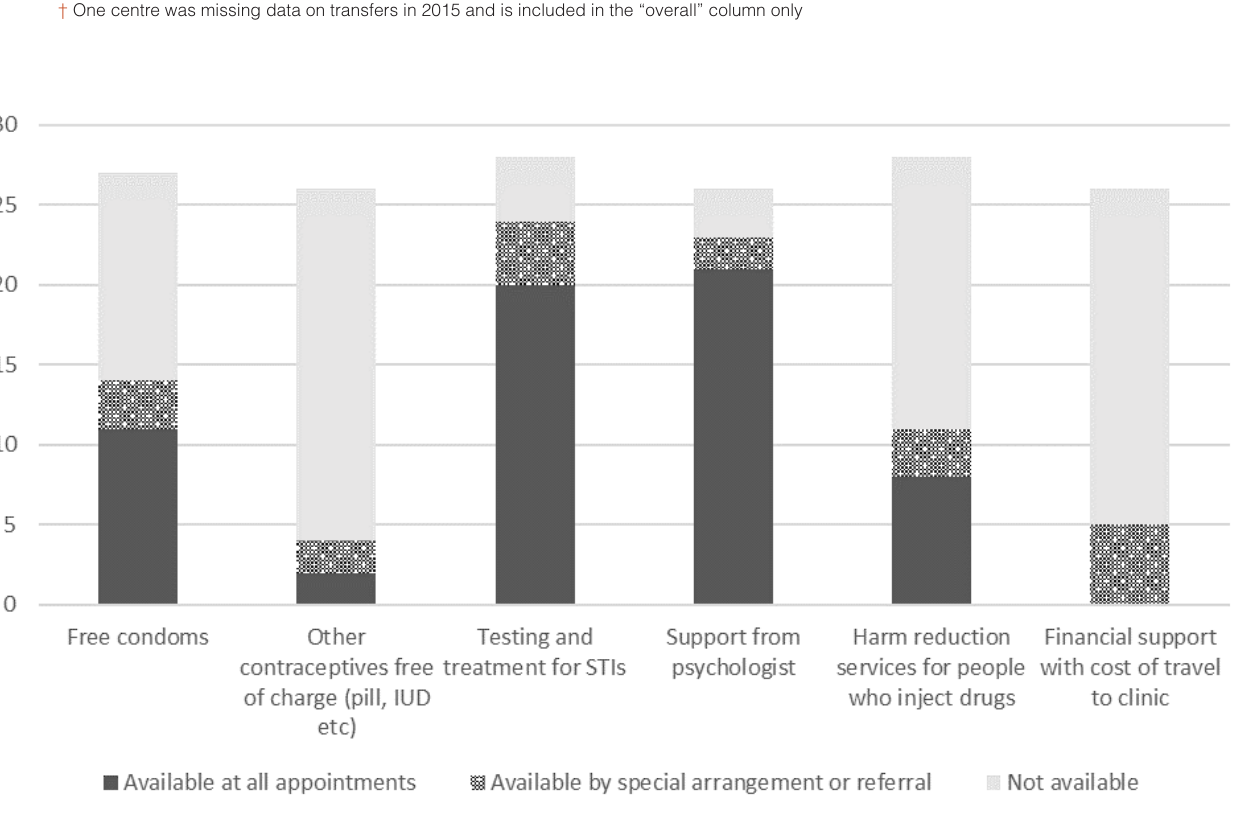
Figure 2. Of 24 regional and 4 municipal centres in Ukraine, the number with each support service available. Bars differ in height due to missing